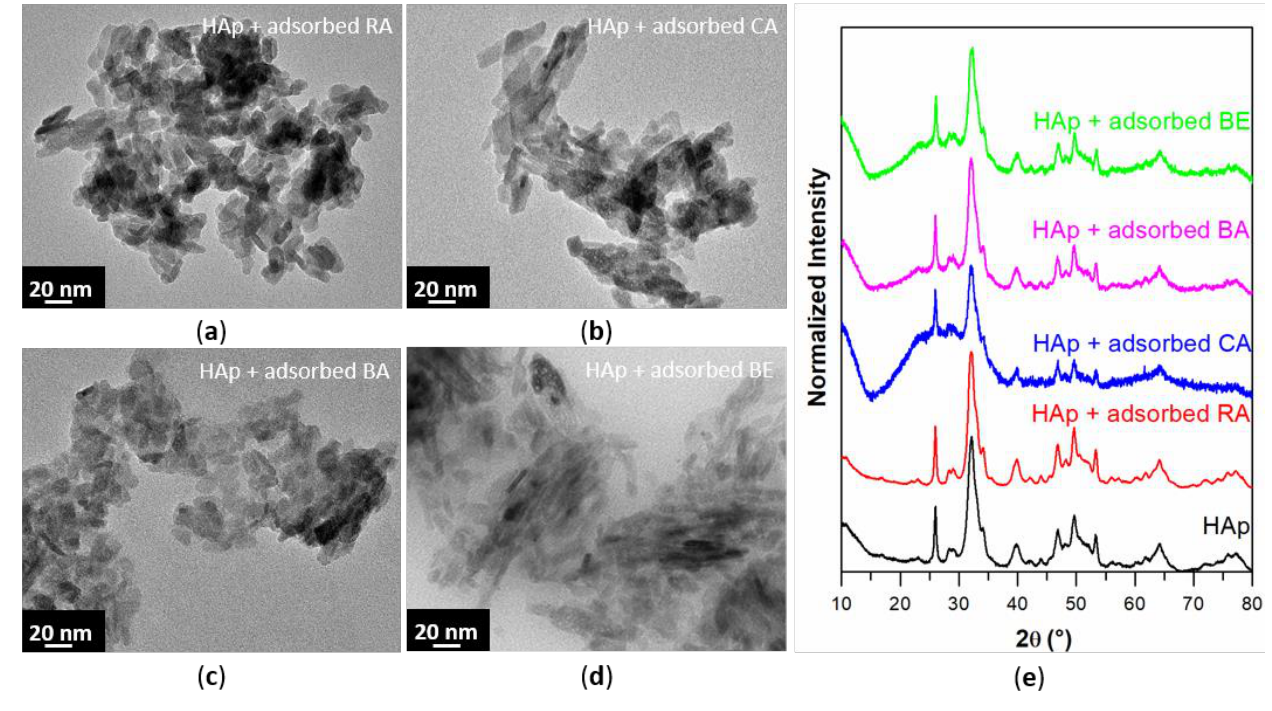
Figure 3. Hydroxyapatite particles after adsorption of polyphenol. TEM images of HAp NPs after adsorption of ( a ) rosmarinic acid; ( b ) chlorogenic acid; ( c ) baicalin; ( d ) baicalein. ( e ) Superimposition of X-ray diffractogram of HAp NPs before and after adsorption of polyphenols. The observed decrease in signal-to-noise ratio in presence of BA, BE, and Ca can be attributed to the low quantity of powder used for the XRD measurement.